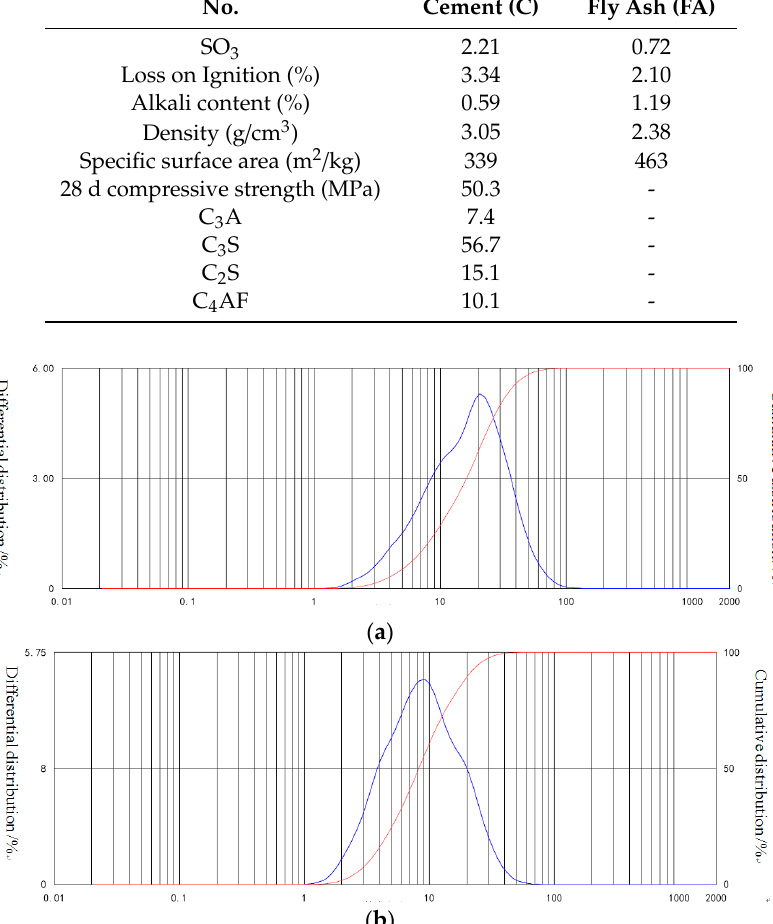
Figure 1. Particle sizes distribution of C and FA: ( a ) cement ( μ m) ; ( b ) fly ash ( μ m).